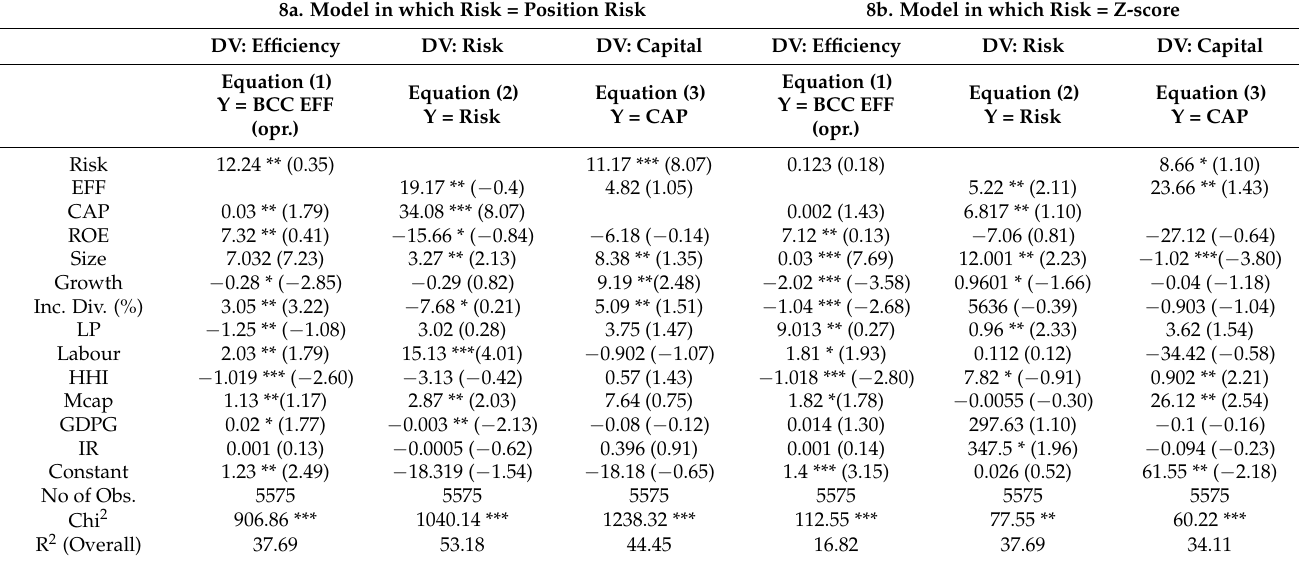
Table 8. Three-stage least-squares estimation of the relationship between securities firms’ capital, risk, and operational